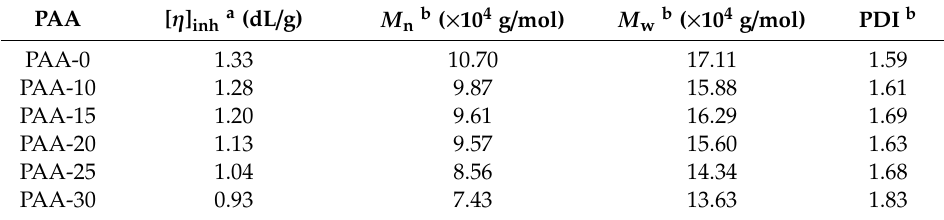
Figure 4. Preparation procedure of PI films.